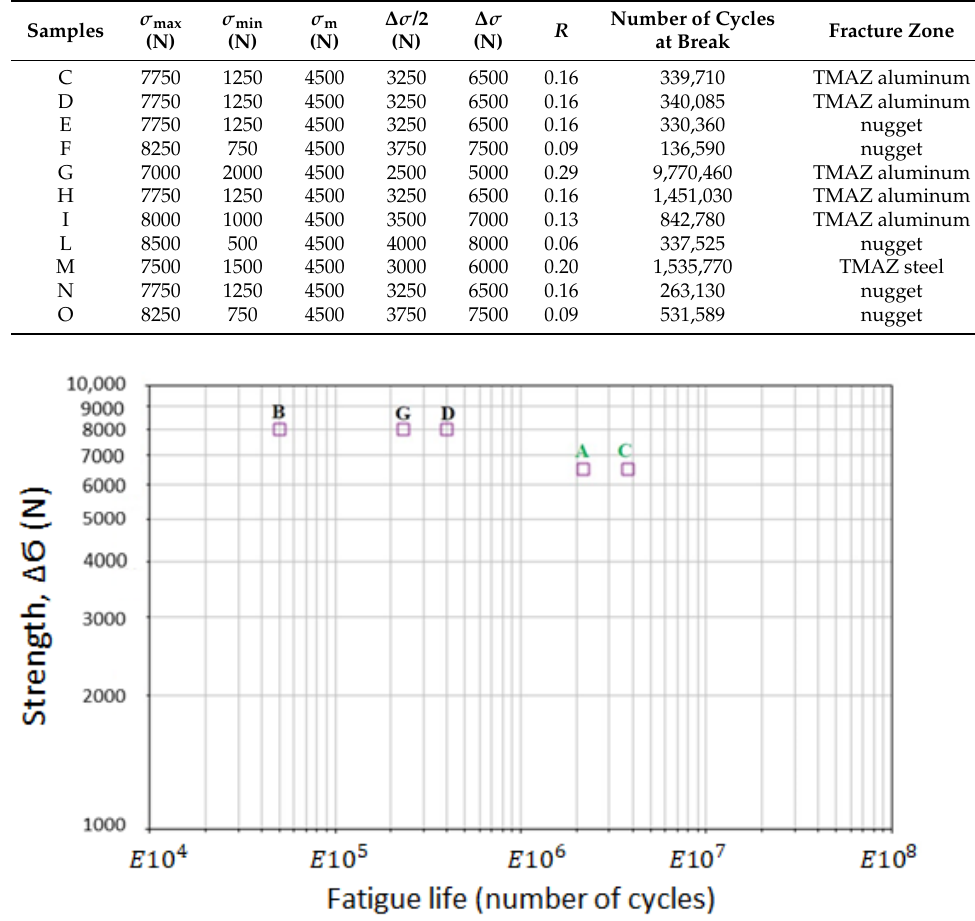
Figure 13. Number of cycles at break for sample 957. Table 6. Fatigue test process parameters and results on sample 9.